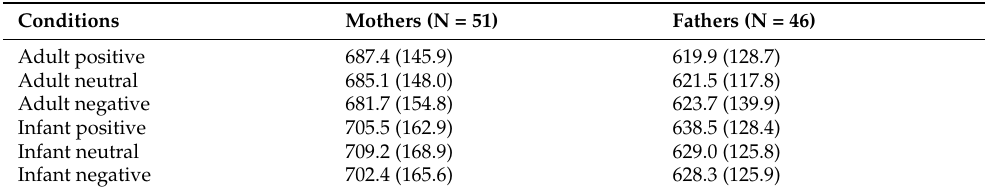
Table 2. Mean (SD) of the non-log transformed RTs as a function of the different conditions in mothers and